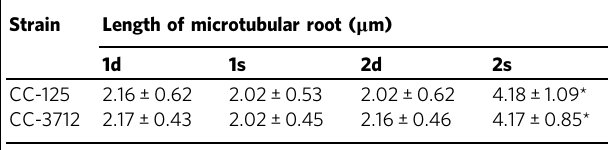
pairs, respectively (binomial test, p < 0.01, parameter θ = 0.5) (Fig. 4f). Because the mating structure of the wild-type (mt + )